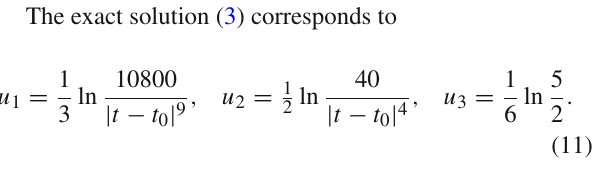
tending to −∞ . The latter may happen only for t → ∞ (for the case t > t 0